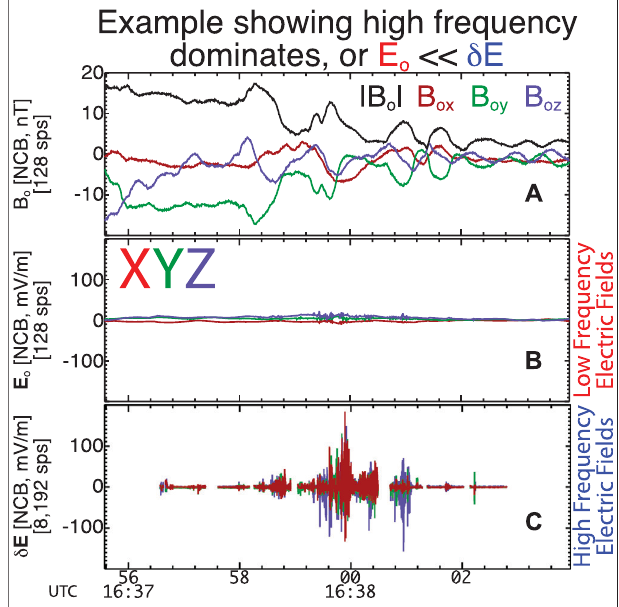
FIGURE 2 | An example terrestrial bow shock crossing observed by THEMIS-C on 2009-09-05. Panel (A) shows the magnetic fi eld magnitude (black) and three normal incidence frame coordinate basis (NCB) (Scudder et al., 1986a) components vs time at 128 samples/second (sps) observedbythe fl uxgate magnetometer (Auster et al.,2008).Panel (B) shows the DC-coupled electric fi eld at 128 sps observed by EFI (Bonnell et al., 2008; Cully et al., 2008). Panel (C) shows the AC-coupled electric fi eld at 8,192 sps observed by EFI. Note that Panels (B , C) share the same verticalaxis range for direct comparison (Adapted from Figure I:2 in Wilson et al.